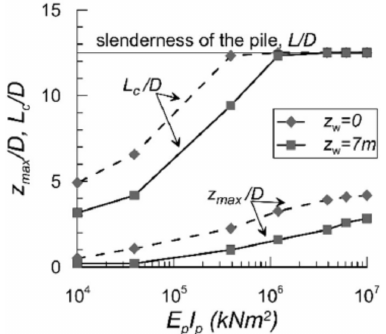
Figure 17. Position of the maximum bending moment and critical length in function of the flexural